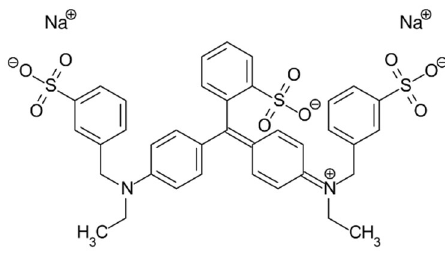
Figure 2. Structural formula of Acid Blue 9